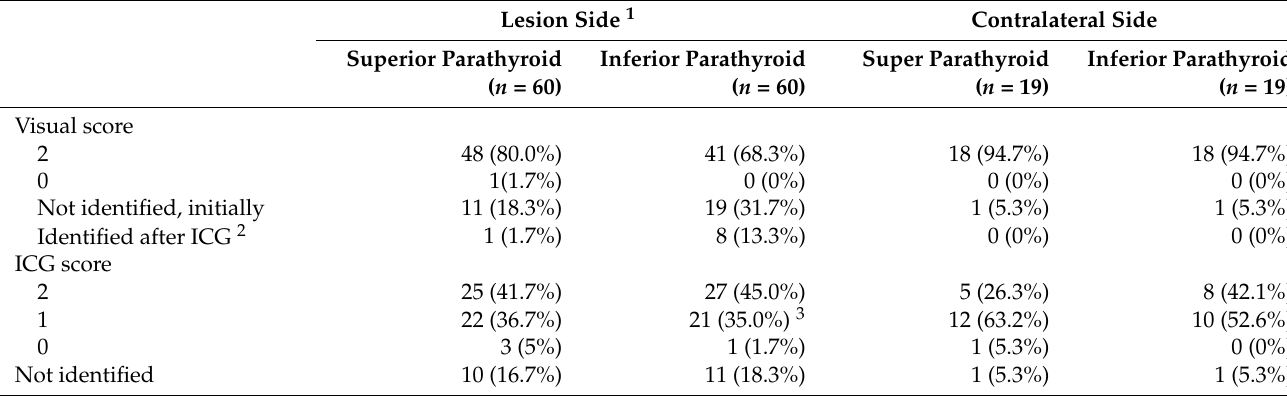
Table 2. Intraoperative parathyroid scoring with visual inspection followed by indocyanine green angiography.